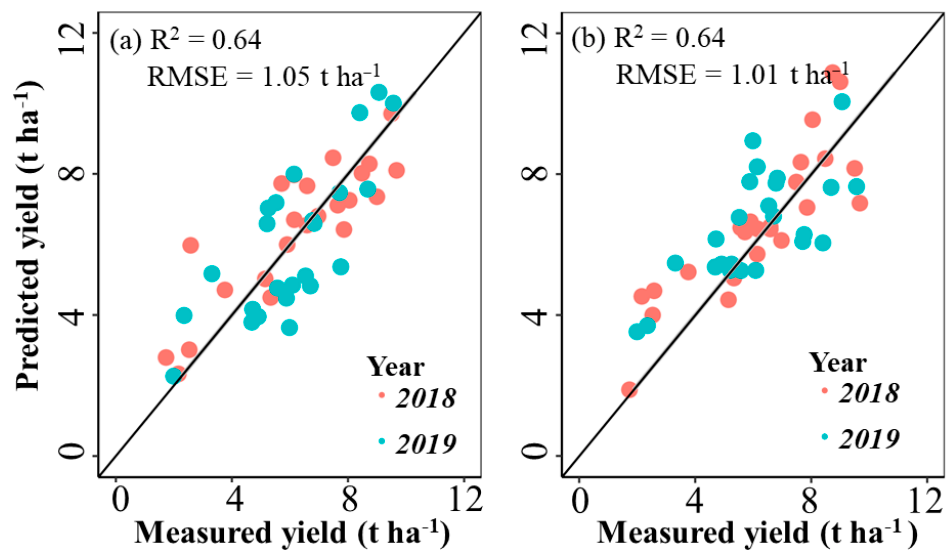
Figure 7. Scatter plots of measured yield versus predicted yield (tons per hectare): transfer learning method ( a ) and data assimilation ( b ).